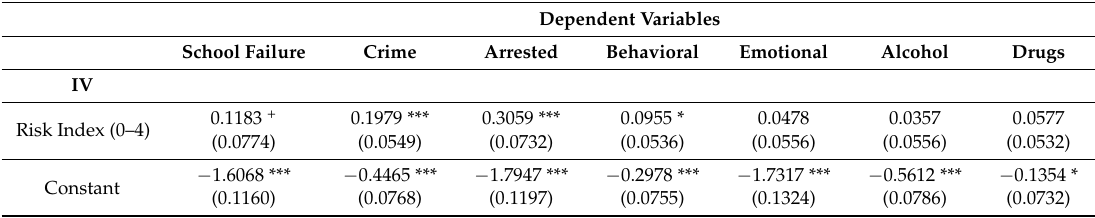
Table 7. Probit Regression using Risk Index